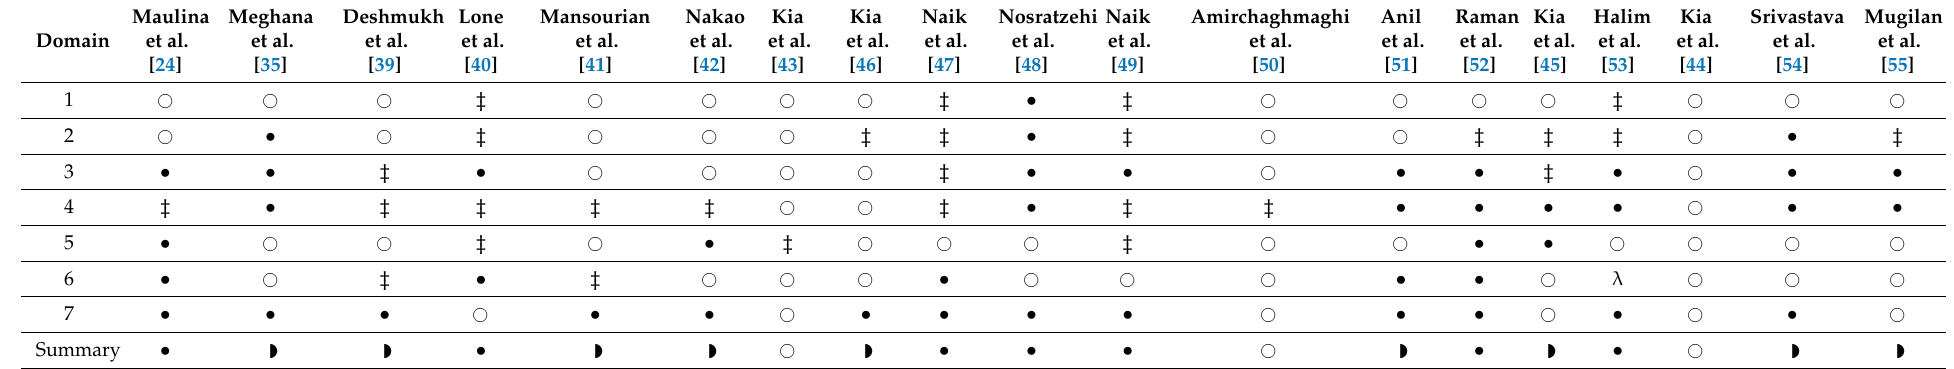
Table 6. Risk of bias assessment using the Cochrane risk of bias